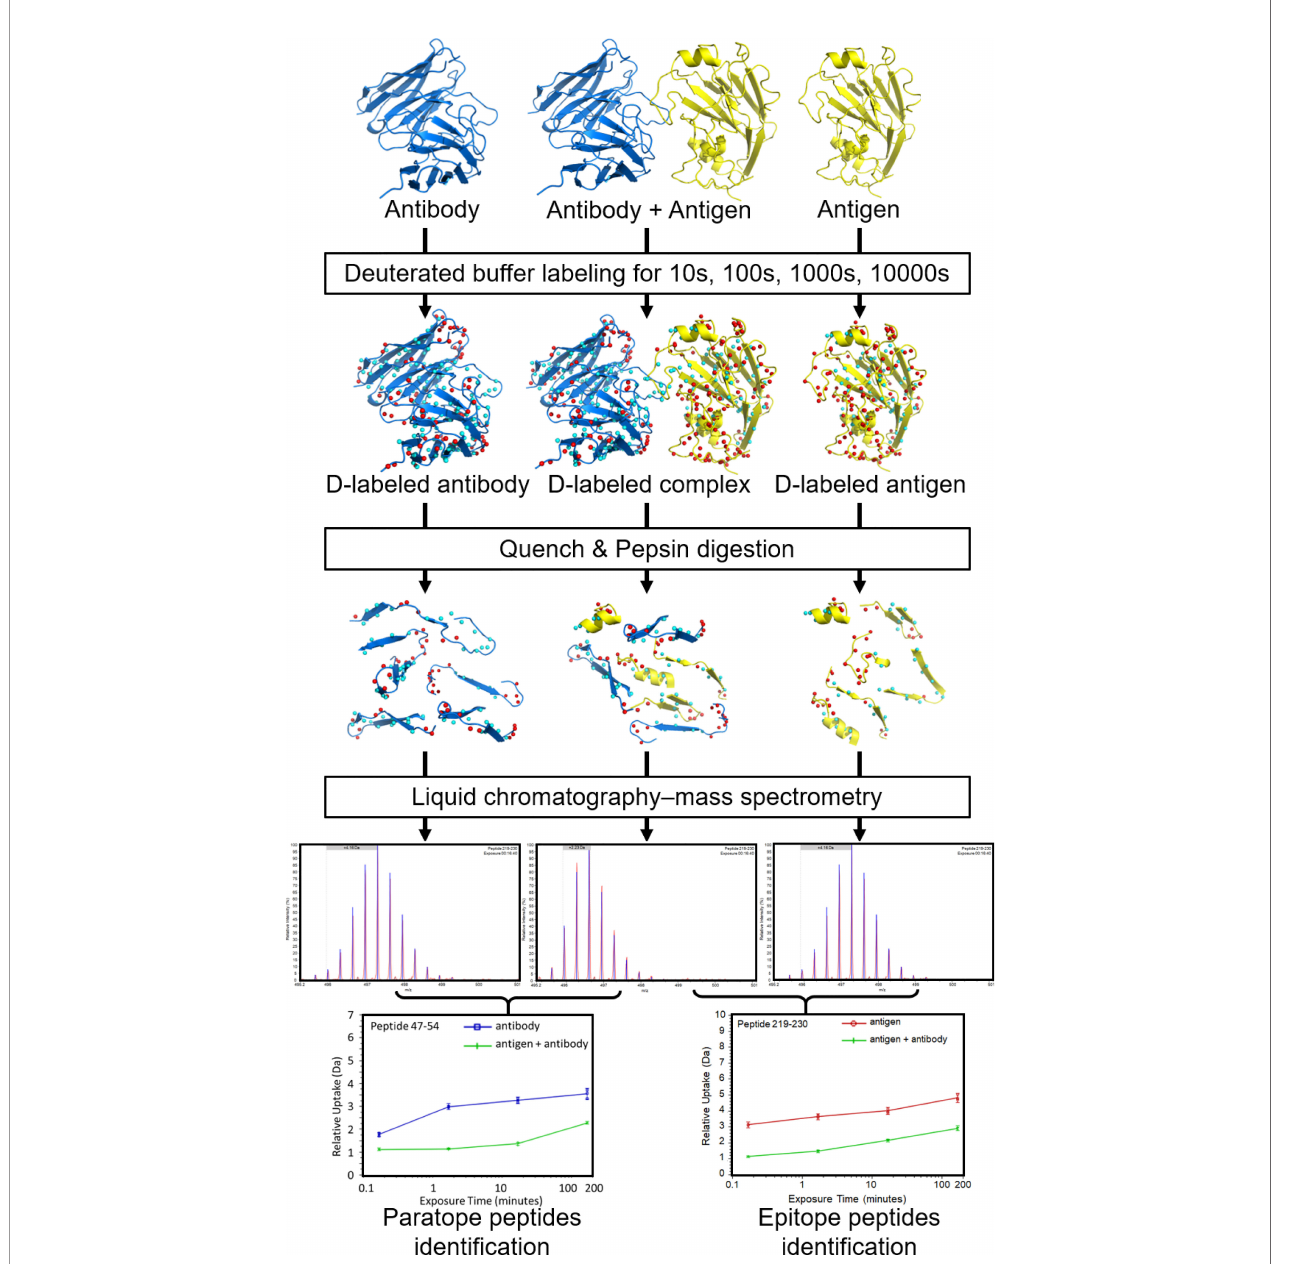
FIGURE 1 | Overview of a typical work fl ow for an epitope/paratope mapping HDX-MS experiment. Separately, the Ag, Ab-Ag complex, and Ab are labeled in D 2 O and incubated for varying lengths of time. The reactions are then quenched at low pH and low temperature. The protein samples are digested (typically with pepsin) to generate peptide fragments. Peptide fragments from each sample are analyzed using LC-MS to identify mass differences at various time points. The D uptake altered by binding enables identi fi cation of putative paratope and epitope peptides. Figure is adapted from